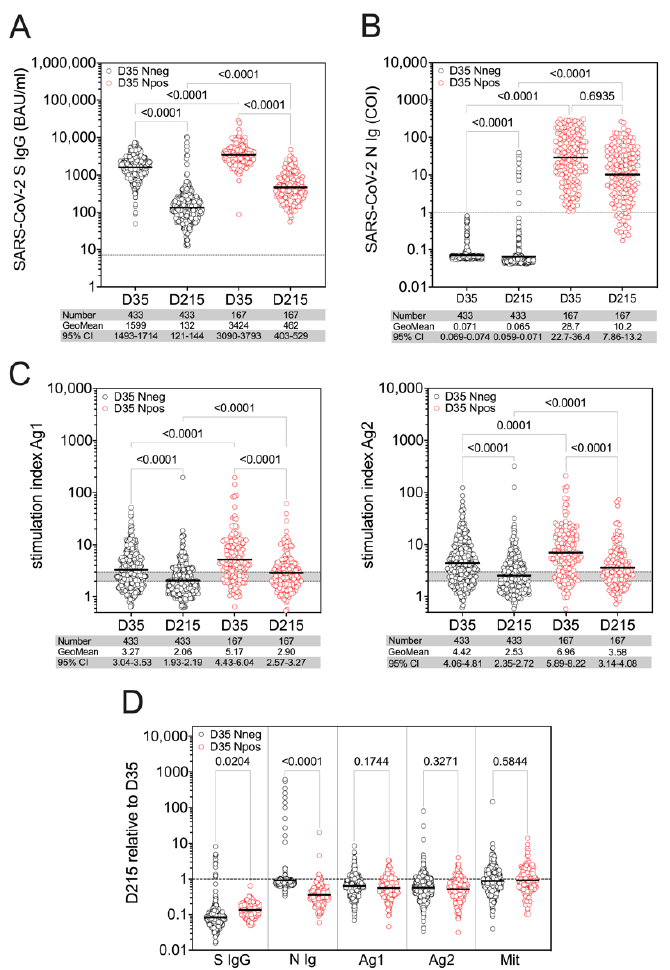
Figure 2. Levels and persistence of SARS-CoV-2-specific immune responses after vaccination in individuals convalescent from SARS-CoV-2 infection (D35 Npos, red symbols) or not (D35 Nneg, black symbols) prior to vaccination. Serum levels of SARS-CoV-2 S- ( A ) and N-specific ( B ) antibodies are shown in samples collected at D35 and D215. T cell response ( C ) is presented as the stimulation index (SI) for SARS-CoV-2-specific Ag1 and Ag2. ( D ) Relative response in D35 Nneg and Npos groups for S IgG, N Ig, Ag1, Ag2 and Mit calculated from values measured at D215 relative to D35. Differences of immune parameters between baseline and follow-up and between individuals with and without prior SARS-CoV-2 infections were tested by applying non-parametric Kruskal–Wallis test followed by Dunn’s multiple comparisons.